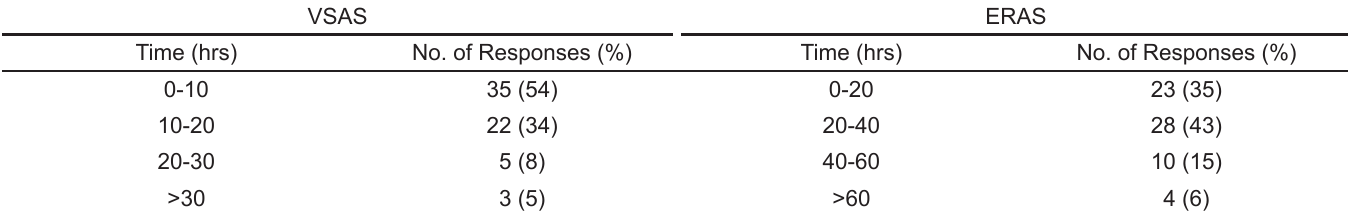
Table 2. Total time spent completing VSAS and ERAS by medical